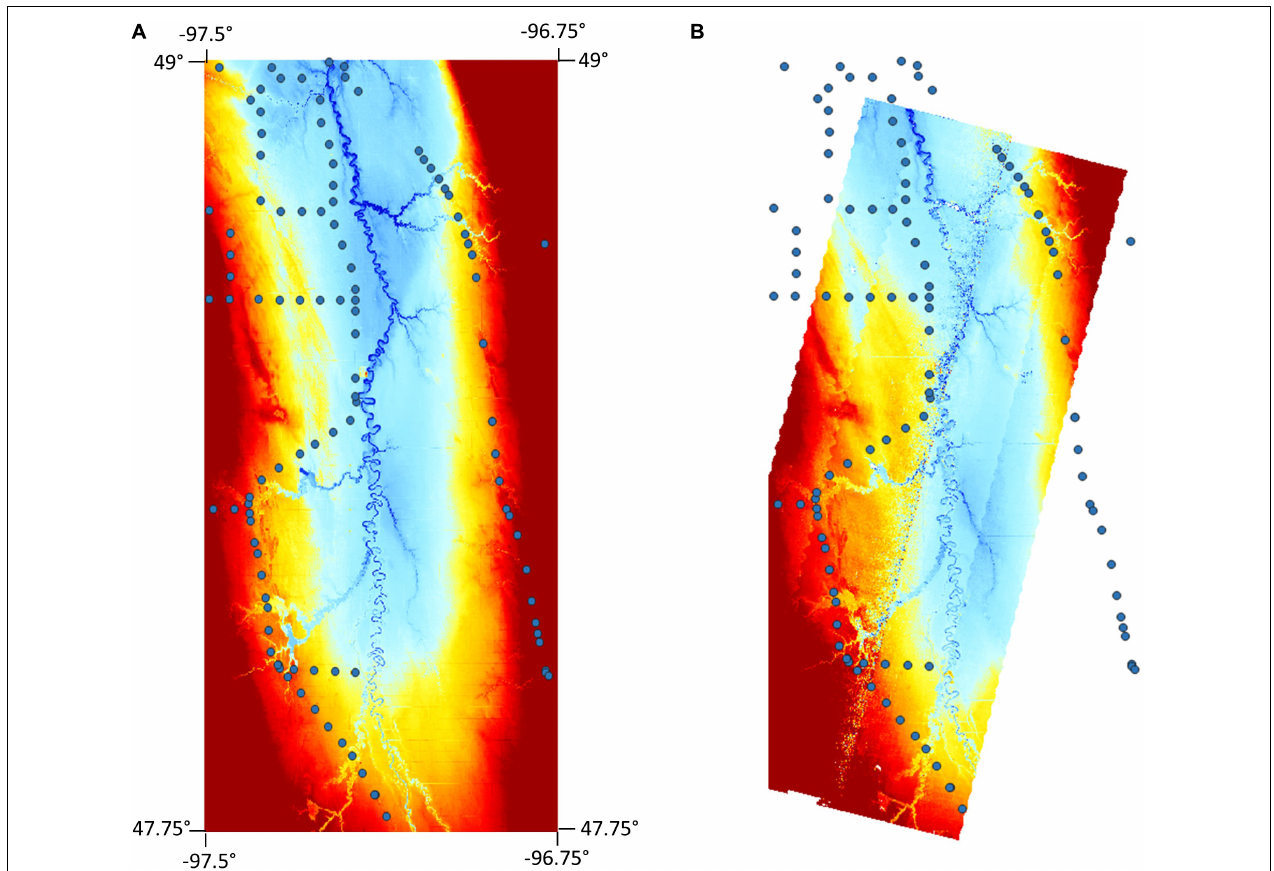
FIGURE 5 | GPS network points overlain digital terrain models from (A) LiDAR and (B) GLISTIN-A InSAR. Height color scales for each DTM are equivalent (210–230 m).